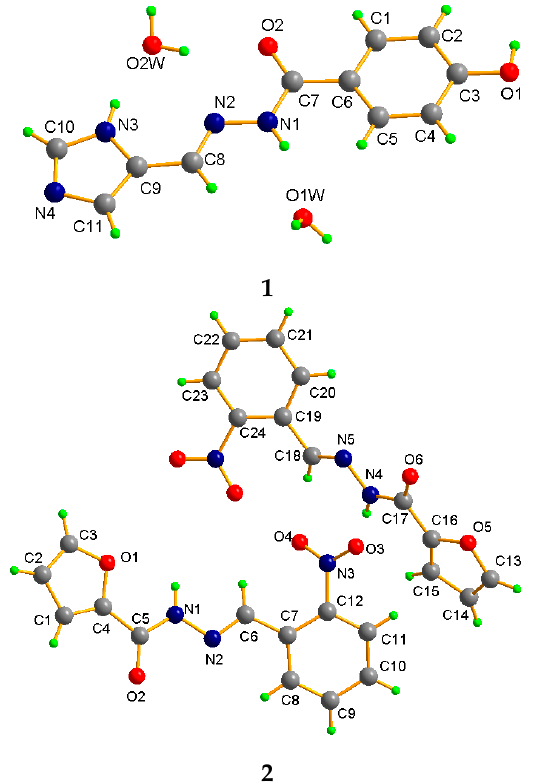
Figure 2. The molecular structure of Compounds 1 and 2.